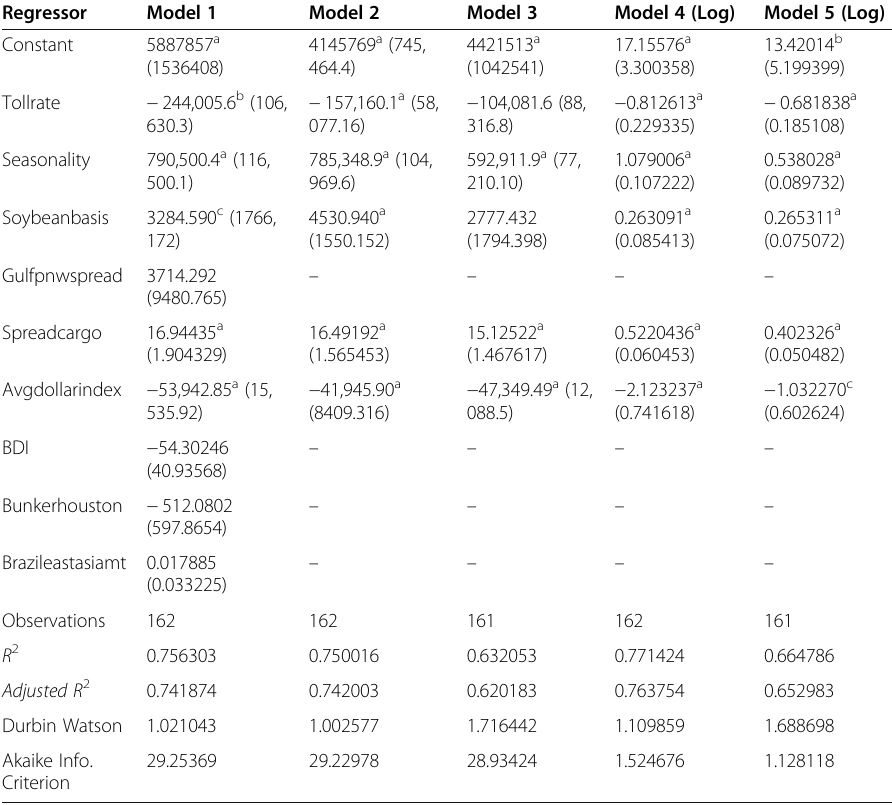
Table 4 OLS estimation of soybean traffic using monthly- transformed data Regressor Model 1 Model 2 Constant